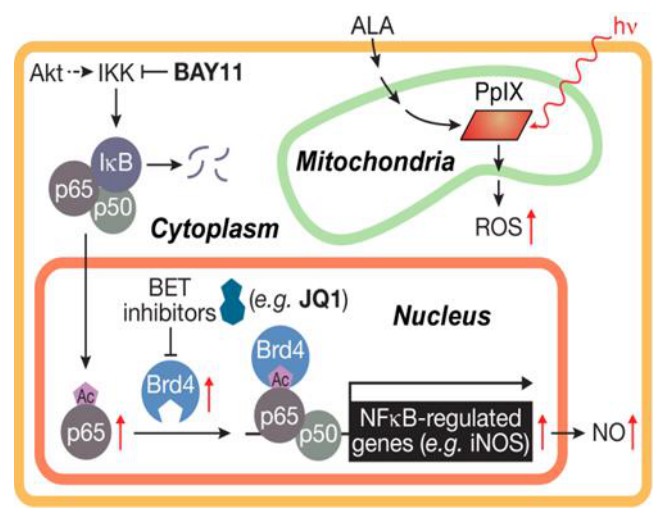
Figure 5. Scheme showing (i) photosensitized generation of ROS ( 1 O 2 ) by ALA-induced PpIX, (ii) activation of NF- κB, (iii) nuclear translocation and acetylation of p65, and (iv) JQ1 -inhibitable transcription of iNOS as mediated by co-activator Brd4. Reproduced from Reference [61], with permission.